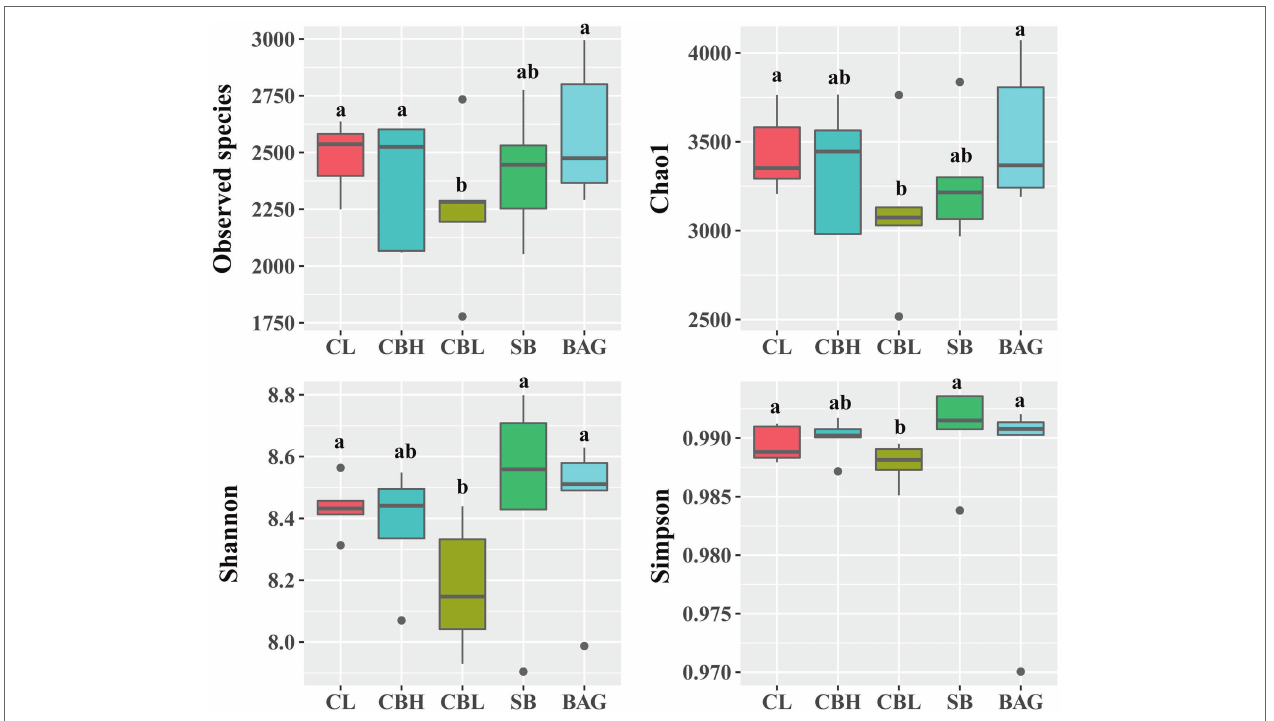
FIGURE 1 | Alpha diversity analysis of intestinal microbiota in different treatments.